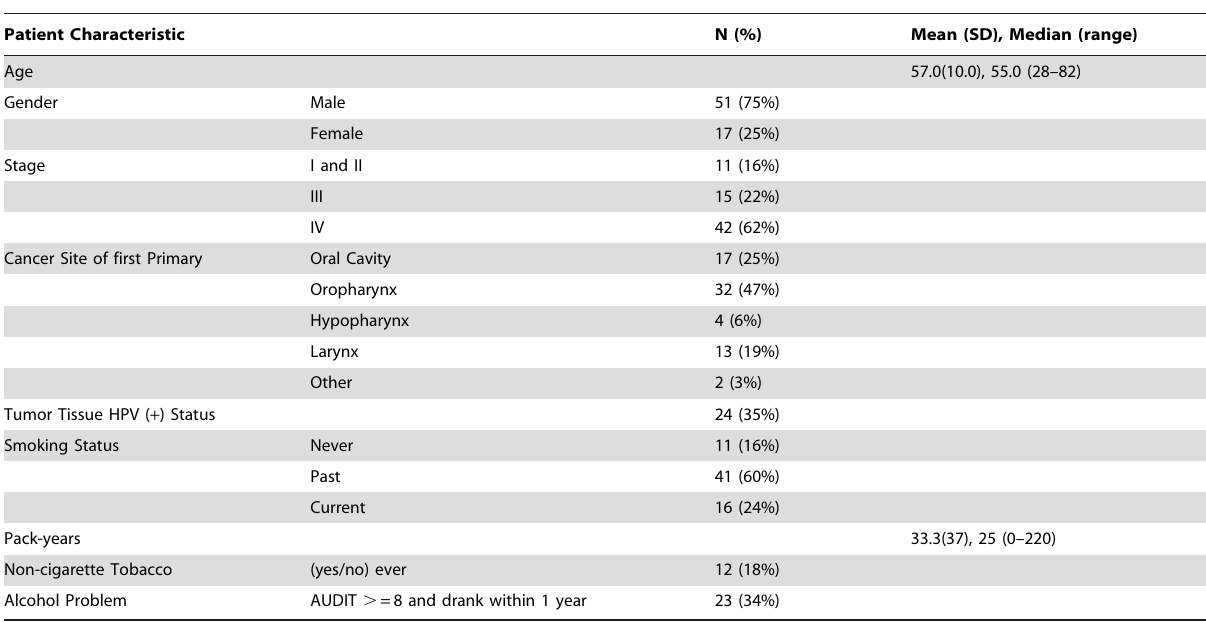
Table 1. Clinical characteristics of the study participants (n=68).